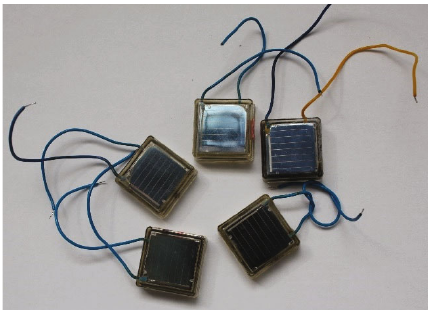
Figure 2: Photovoltaic cell type P + PNN +